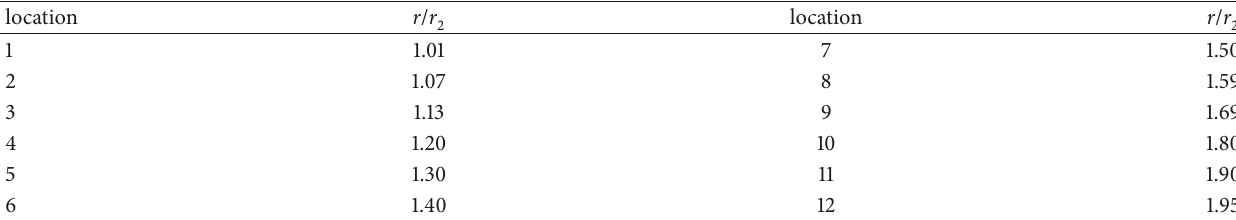
Table 3: Pressure tap locations.